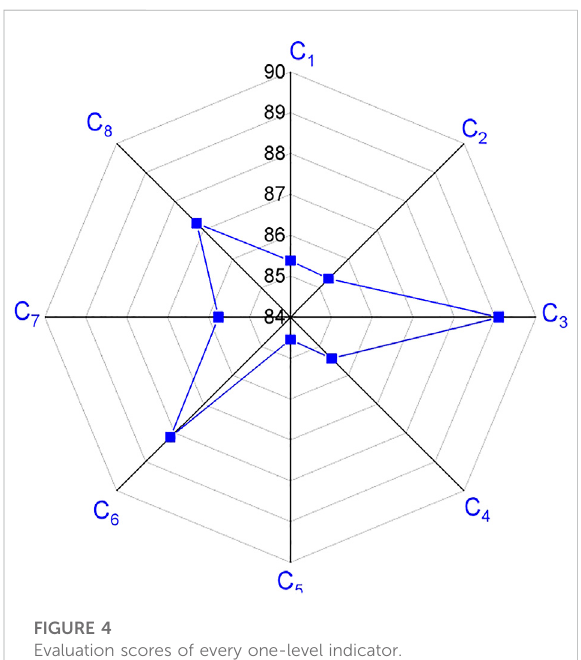
FIGURE 4 Evaluation scores of every one-level